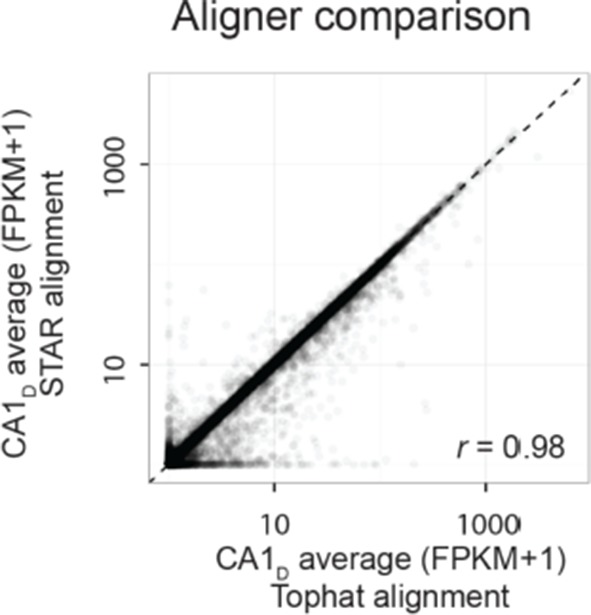
DOI:
http://dx.doi.org/10.7554/eLife.14997.021